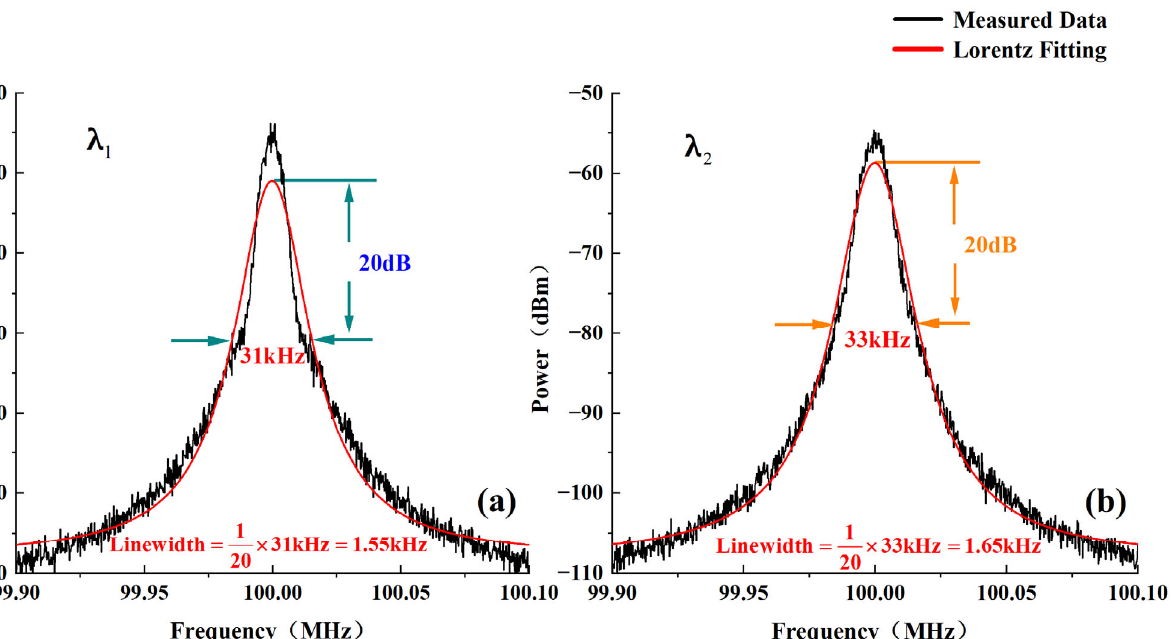
Figure 10. Measurement of the laser’s linewidth by DSHI: measurement results for ( a ) λ 1 and ( b ) λ 2 .